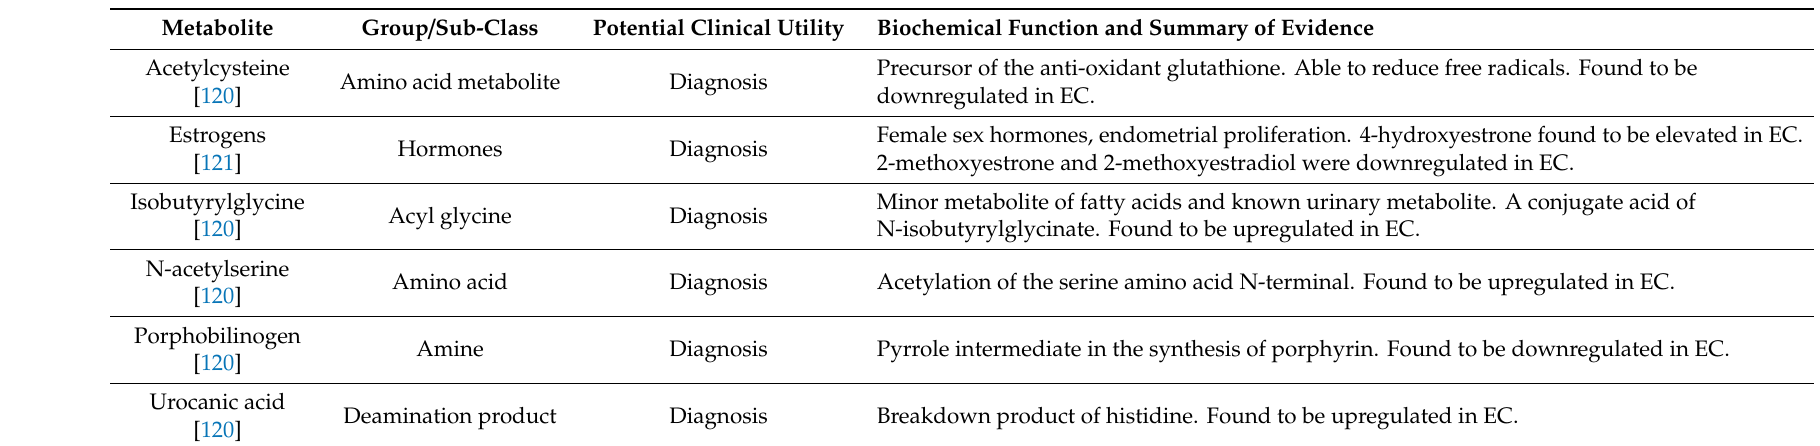
Table 3. Most promising urine-based EC metabolomic biomarker candidates and their